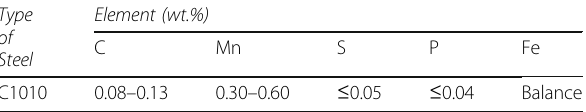
Table 2 Code-names of the coupons in this work